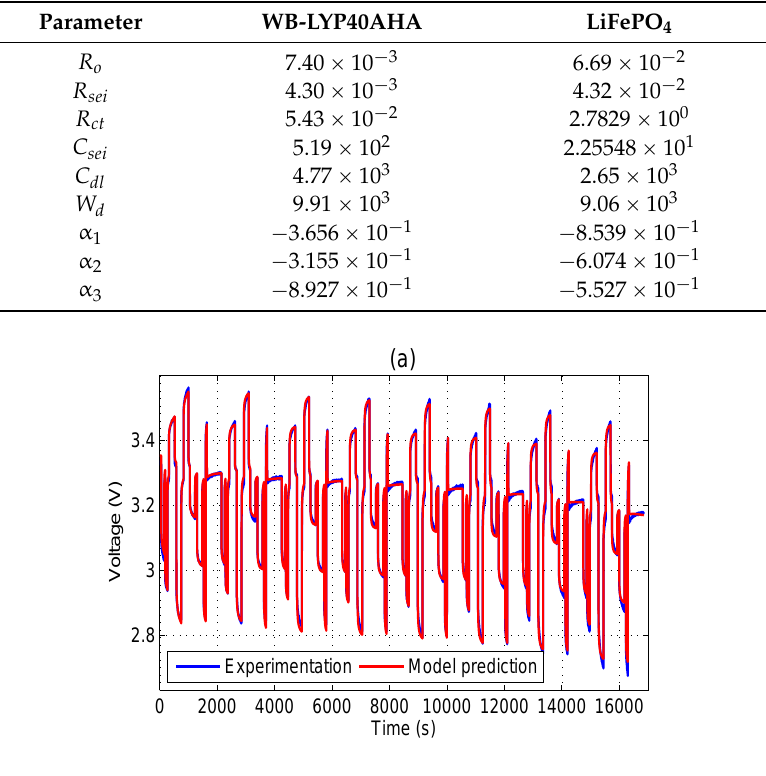
Figure 6. Cont. Figure 6. Cont.